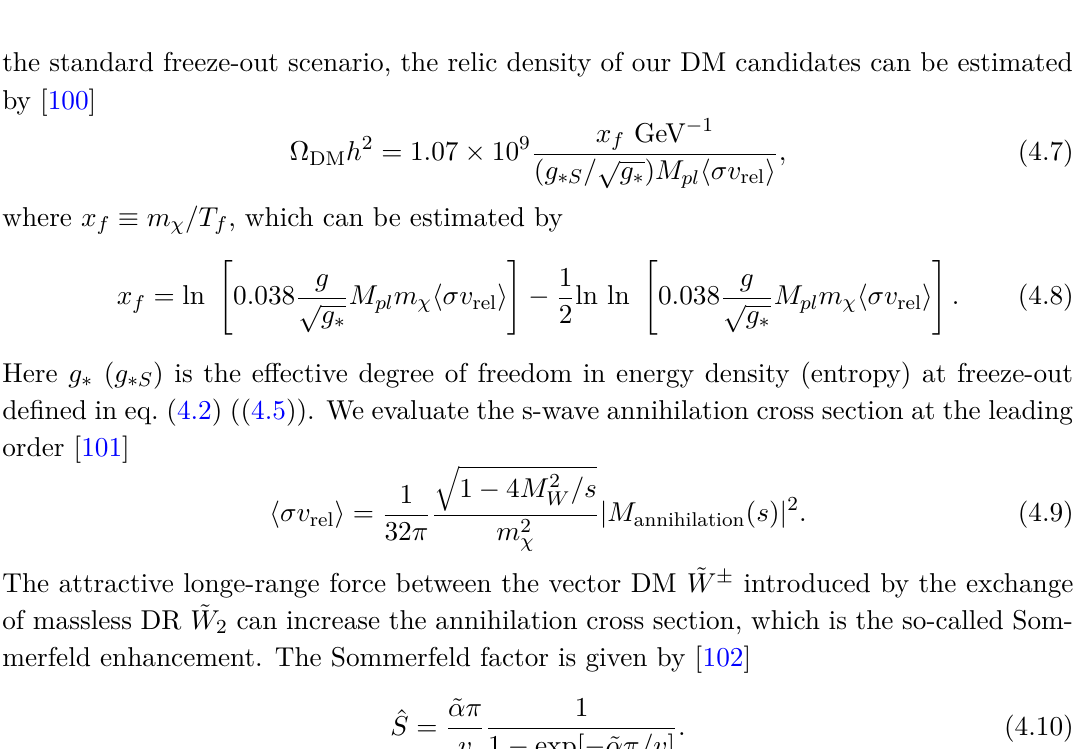
Figure 5. Representative Feynman diagrams for vector DM ˜ W + ˜ W − pair